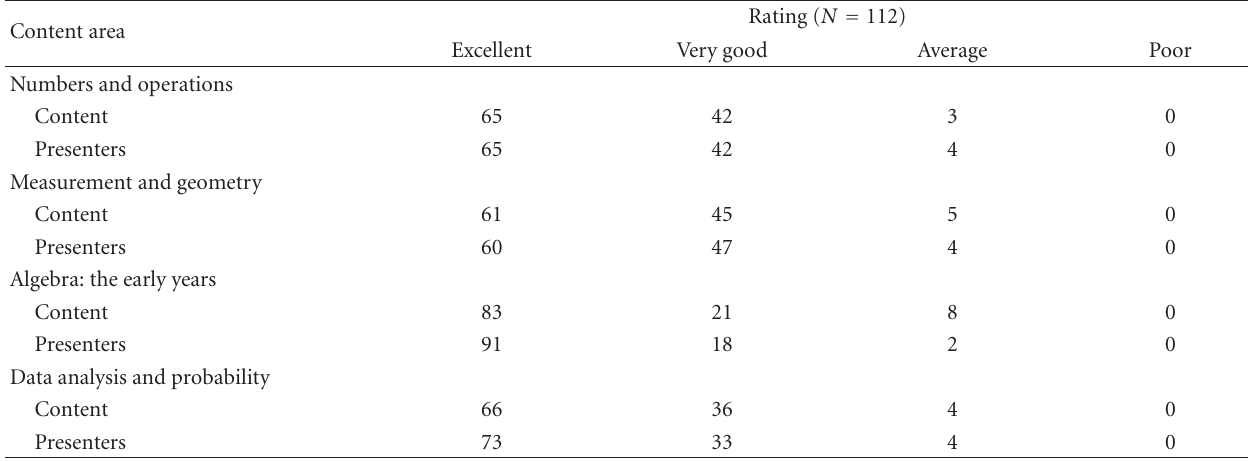
Table 2: Survey results related to mathematics